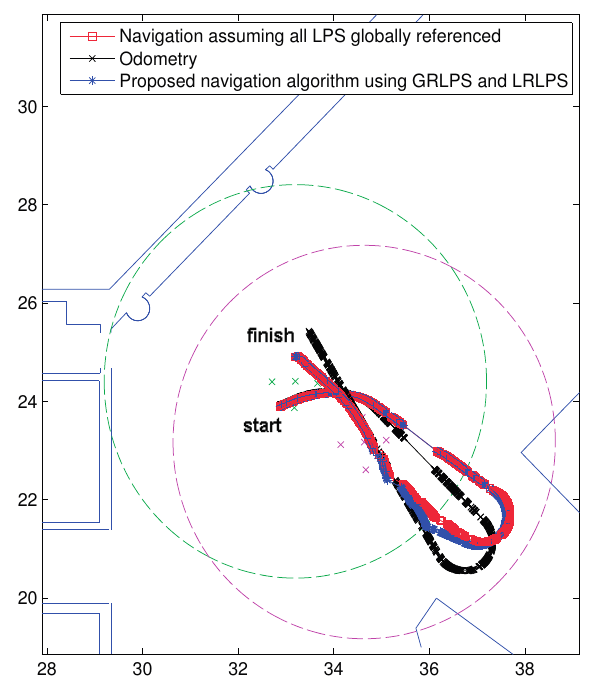
Figure 11. Real results with a GRLPS and an